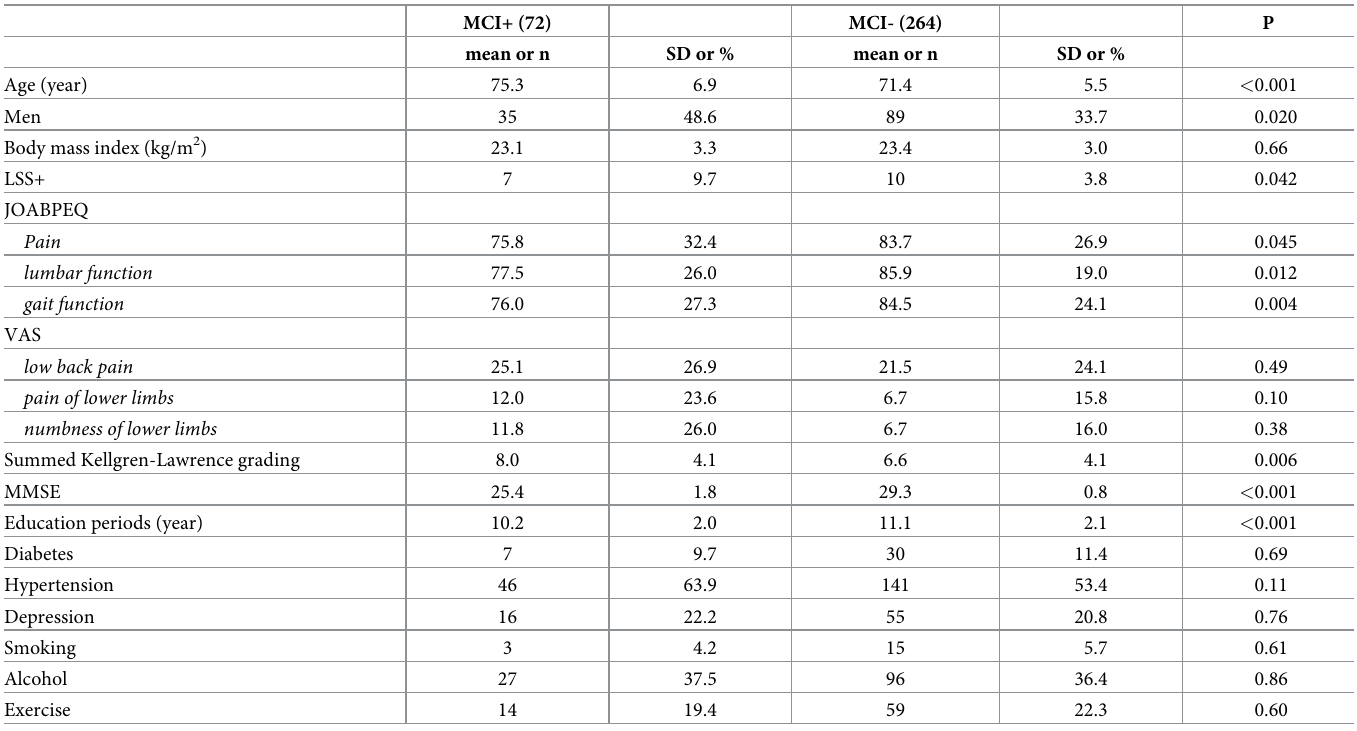
Table 2. Differences in demographic characteristics between groups with and without MCI.